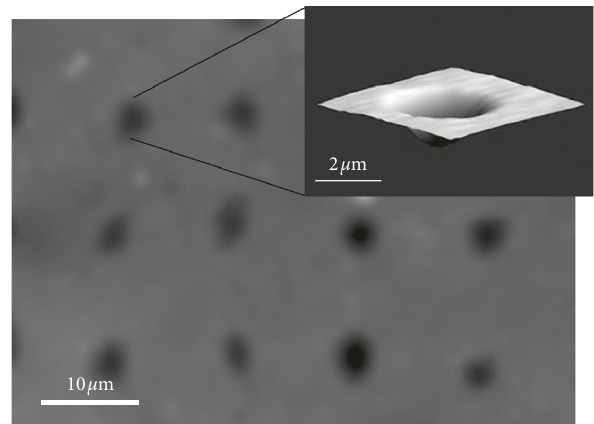
10 µ m Figure 3: AFM image of the negative dot pattern on PDMS and detail of one of the negative dots (upper